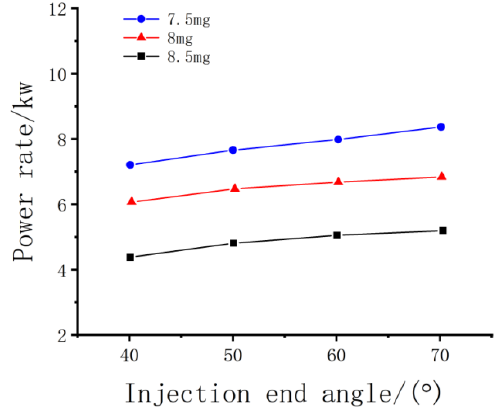
Figure 37. Effect of the injection parameters on engine power.